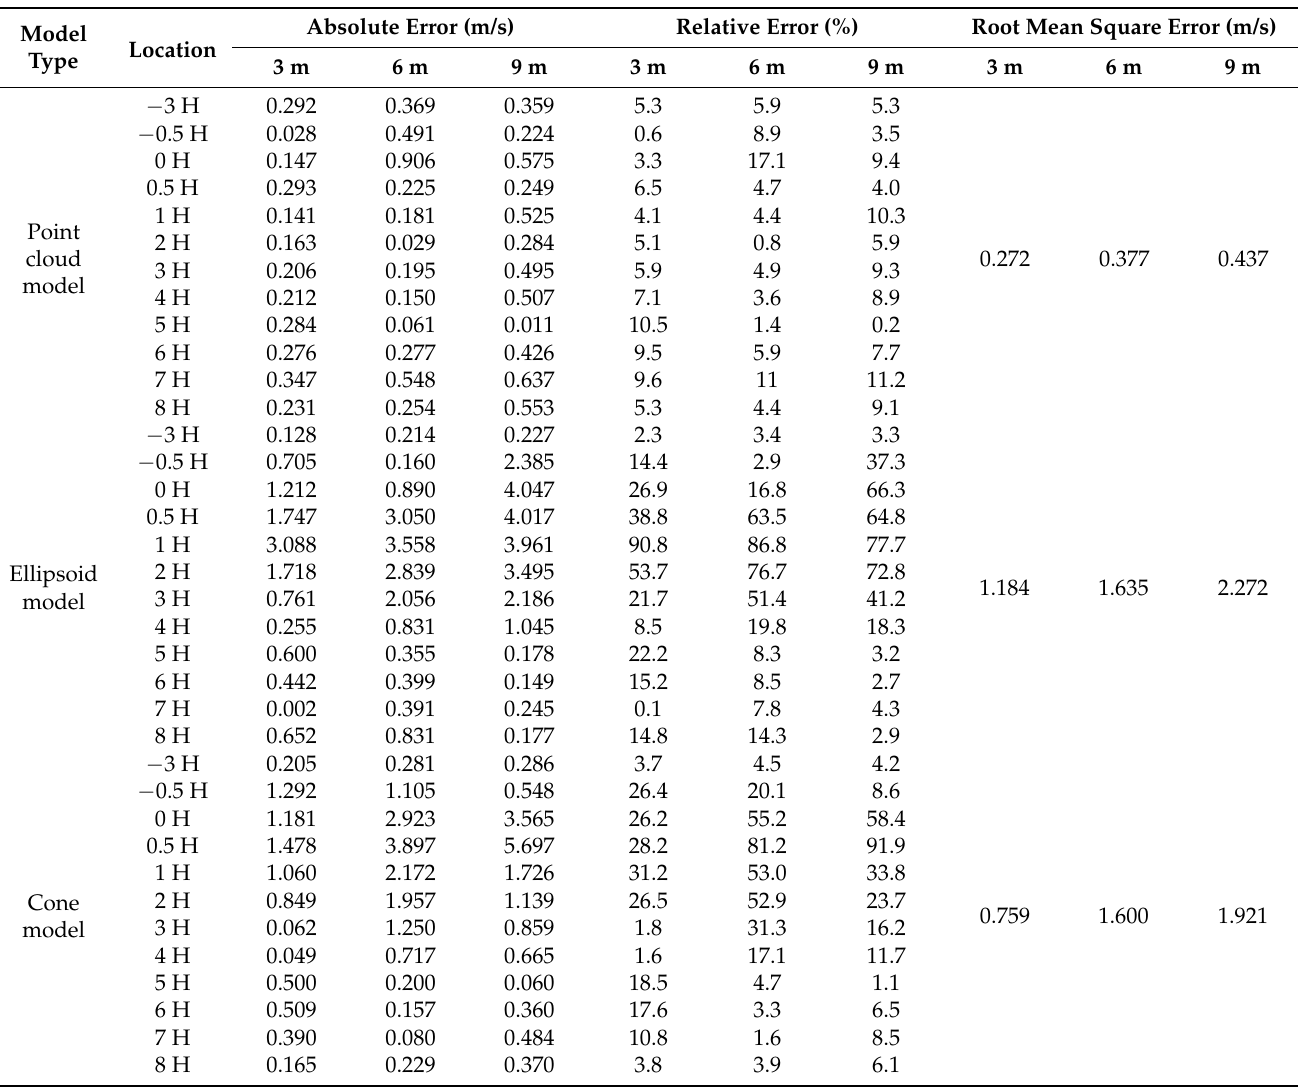
Table 4. Errors of wind field simulation results for three different models are shown.